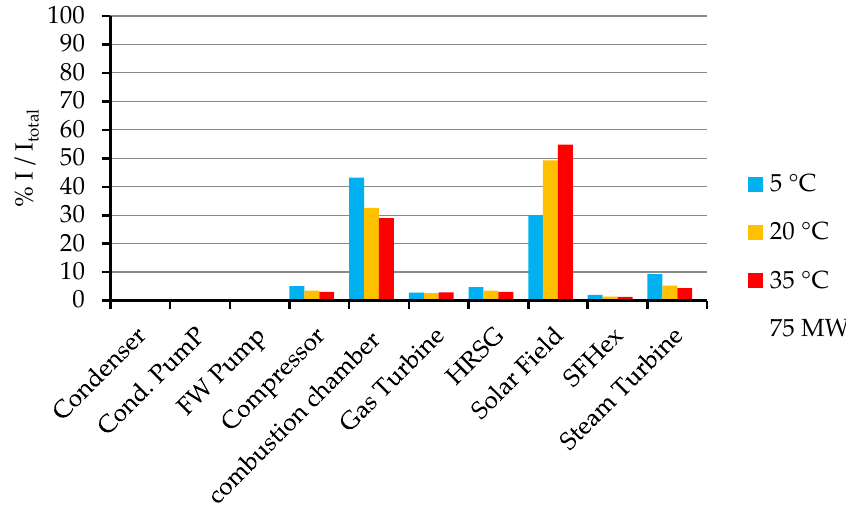
Figure 5. Percentage of exergy destruction in each component of the ISCC out of the total exergy destruction of the plant at different ambient temperatures for solar heat input equal to 75 MW.